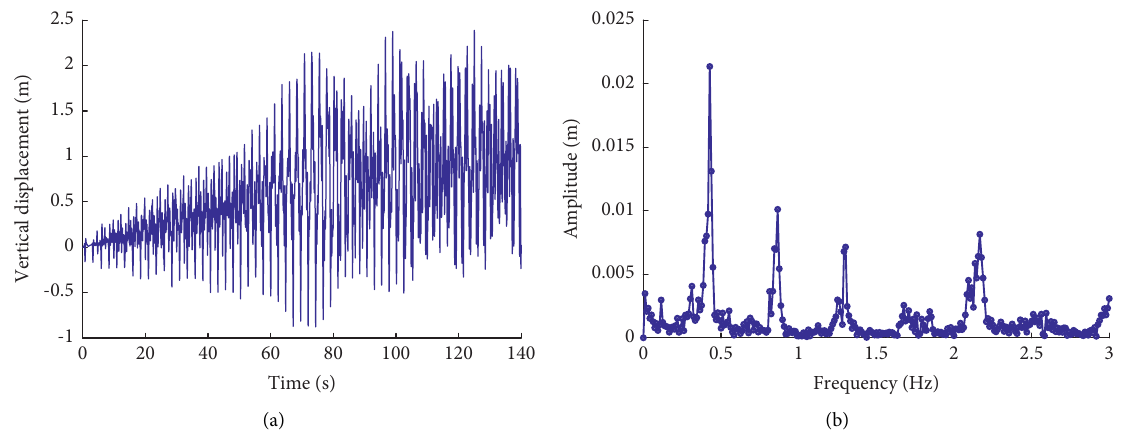
Figure 4: Results of 1/4 point of the line under adaptive excitation. (a) Vertical displacement-time curve. (b) Amplitude